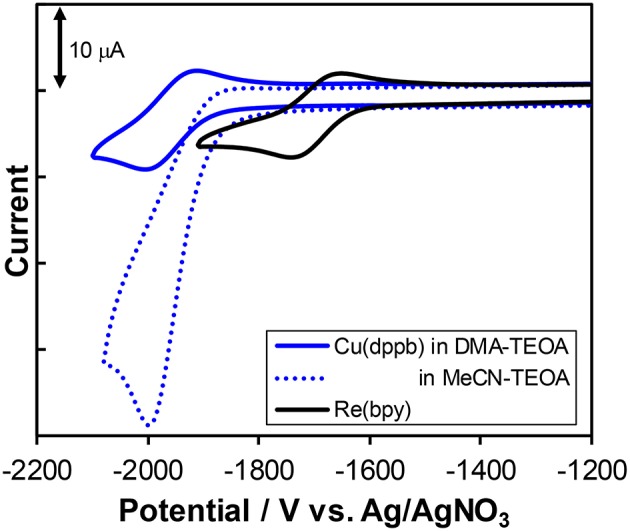
Cyclic voltammograms of Cu(dppb) (blue solid line) and Re(bpy) (black solid line) a mixture of DMA and TEOA (4:1 v/v) containing Et4NPF6 (0.1 M) as a supporting electrolyte with a Ag/AgNO3 (0.01M) reference electrode. The voltammogram of Cu(dppb) measured in a mixture of MeCN and TEOA (4:1 v/v) is also illustrated as a blue dotted line.